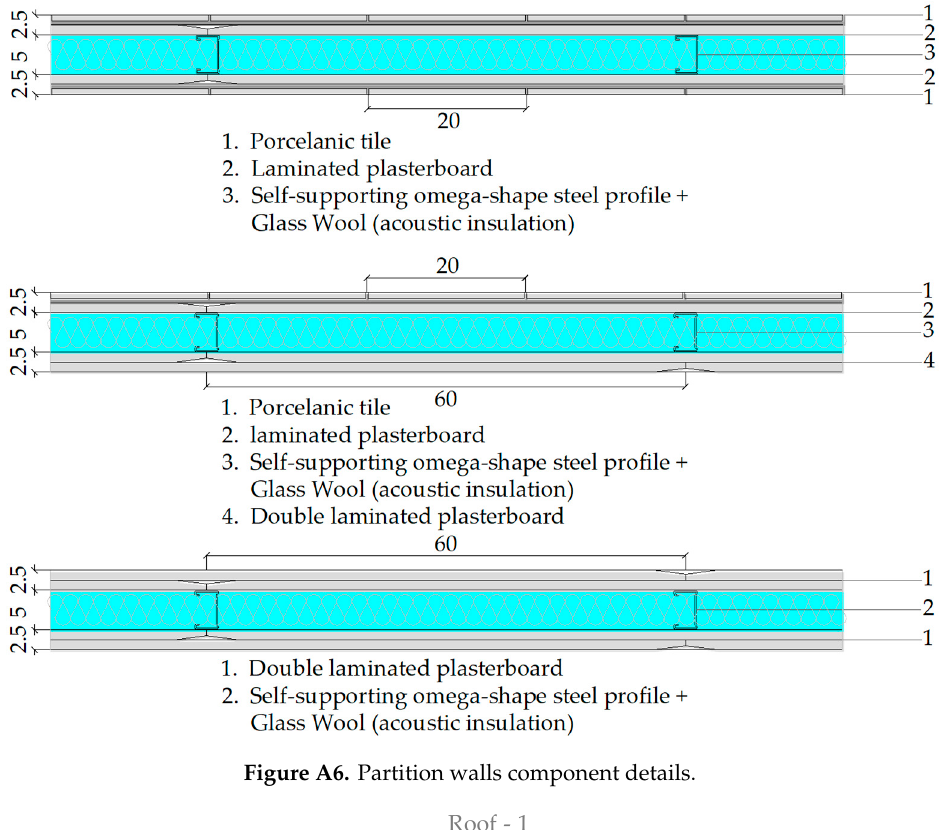
Figure A5. Median walls components detail.